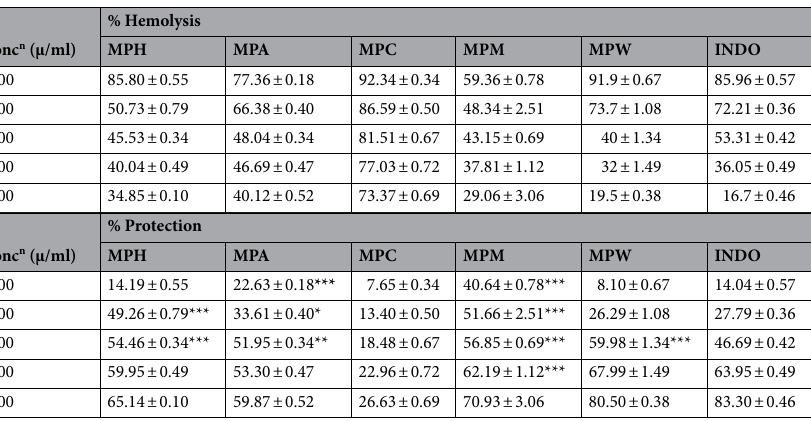
Table 3. Effect of M. paniculata extracts and Indomethacin on HRBC membrane hemolysis and protection. Values are Mean ± SE (n = 3). P value ( *** ): very highly significant; (**): highly significant, (*): significant difference over the standard group (Comparison of ‘r’